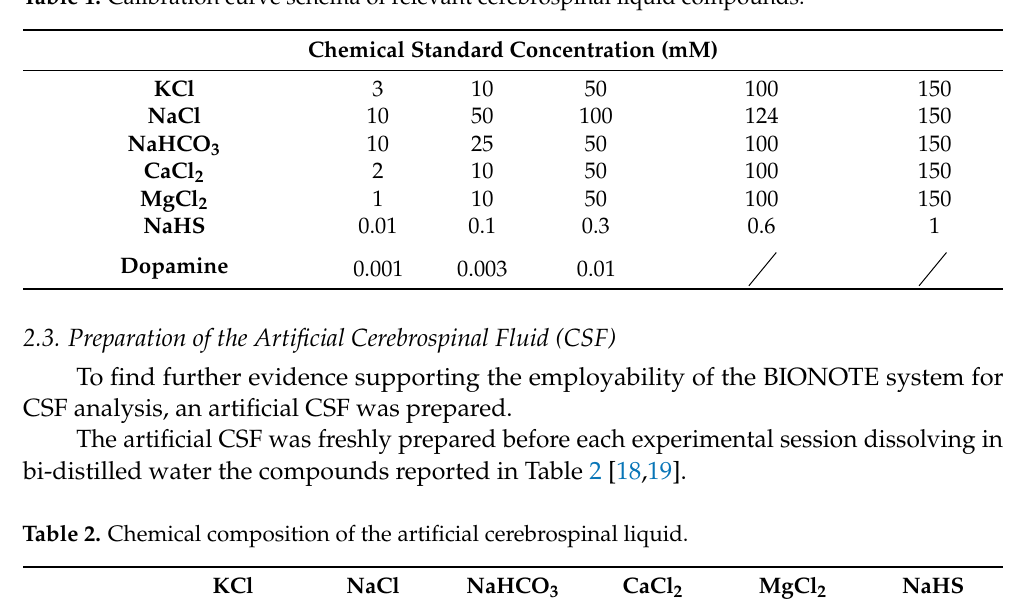
Table 1. Calibration curve schema of relevant cerebrospinal liquid compounds.